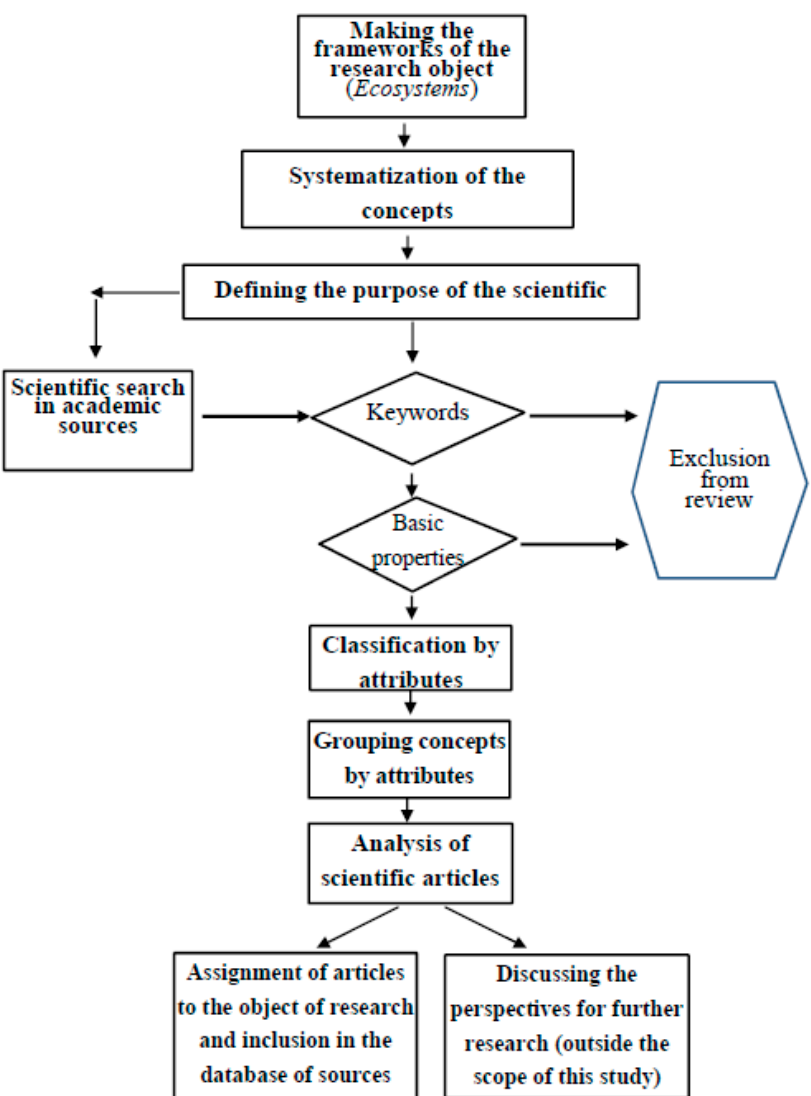
Figure 1. The logic of scientific research in order to systematize the conceptual apparatus.